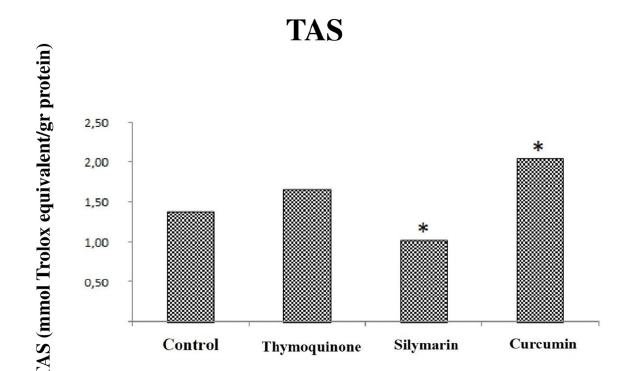
Fig. 1 - Comparison of total antioxidant status (TAS) values between groups. Control = ischemia-reperfusion (I-R) group; Thymoquinone = thymoquinone + I-R group; Silymarin = silymarin + I-R group; Curcumin = curcumin + I-R group. *=statistically significant